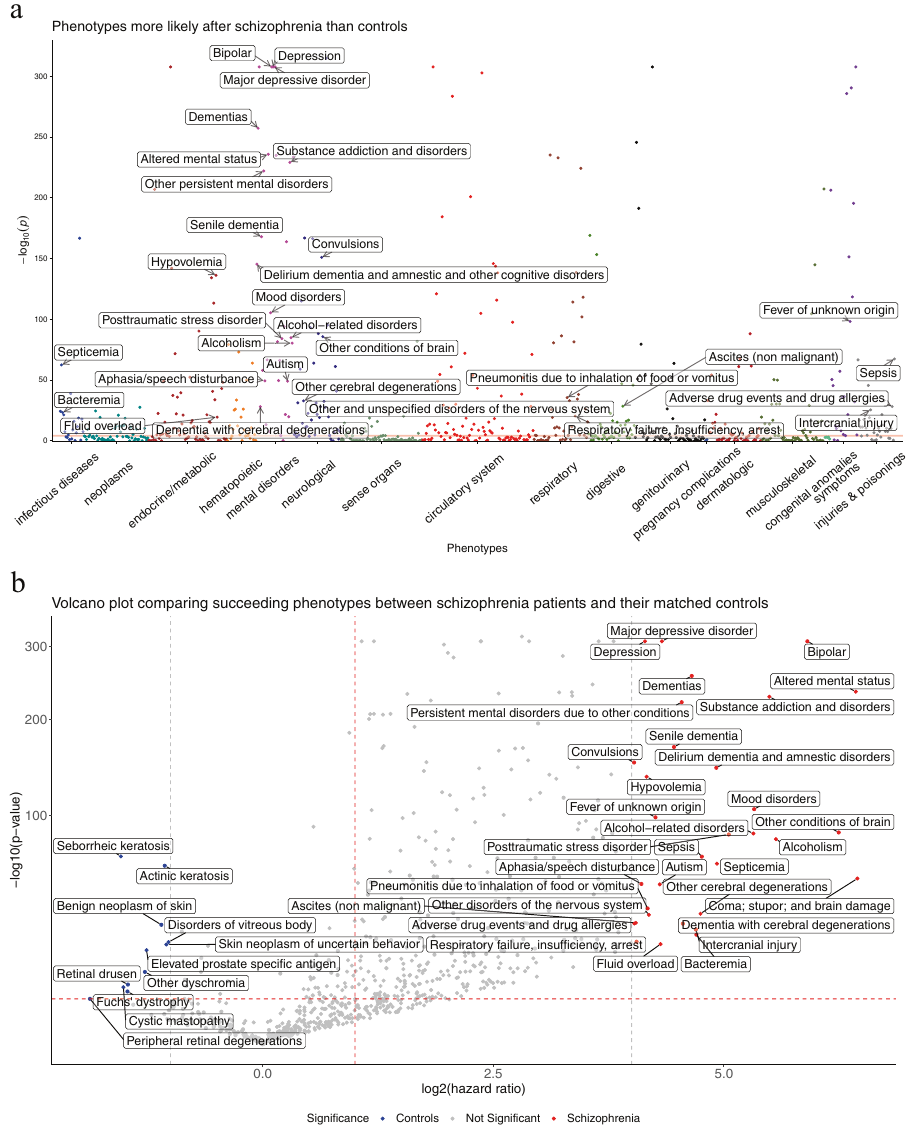
Fig. 2 Systematic analysis of the phenotypes following the clinical diagnosis of schizophrenia. a Manhattan plot of the phenotypes. The red horizontal line indicates a Bonferroni-corrected P -value threshold. Annotated phenotypes have hazard ratios (HRs) ≥ 16. b Volcano plot of the phenotypes. The red horizontal dashed line indicates the same Bonferroni-corrected P -value threshold, the red vertical dashed line designates an HR = 1 threshold, and the gray vertical dashed lines indicate HR = 16 and HR = 0.5. Phenotypes with more extreme HRs are labeled in the fi antisocial and borderline personality disorder after schizophrenia diagnosis compared with non-schizophrenic controls. Middle- aged adults are more likely to develop phenotypes related to respiratory and renal failures, sepsis, convulsions, and pneumonia. Older adults are more likely to have phenotypes related to dementia, delirium, and sepsis. These results indicated that the evolving comorbidity patterns of schizophrenia across age groups. On the other hand, non-schizophrenic controls were more likely to have ICD codes related to routine health checkups on less debilitating symptoms, such as benign neoplasm of skin, elevated prostate-speci fi c antigen, and keratosis. These fi ndings suggest non-schizophrenia participants have better overall health and a higher tendency for seeking preventive care compared with those with schizophrenia. Previous work has developed schizophrenia prediction models [44, 45], which identi fi ed genetic and psychosocial risk factors of schizophrenia in smaller cohorts.